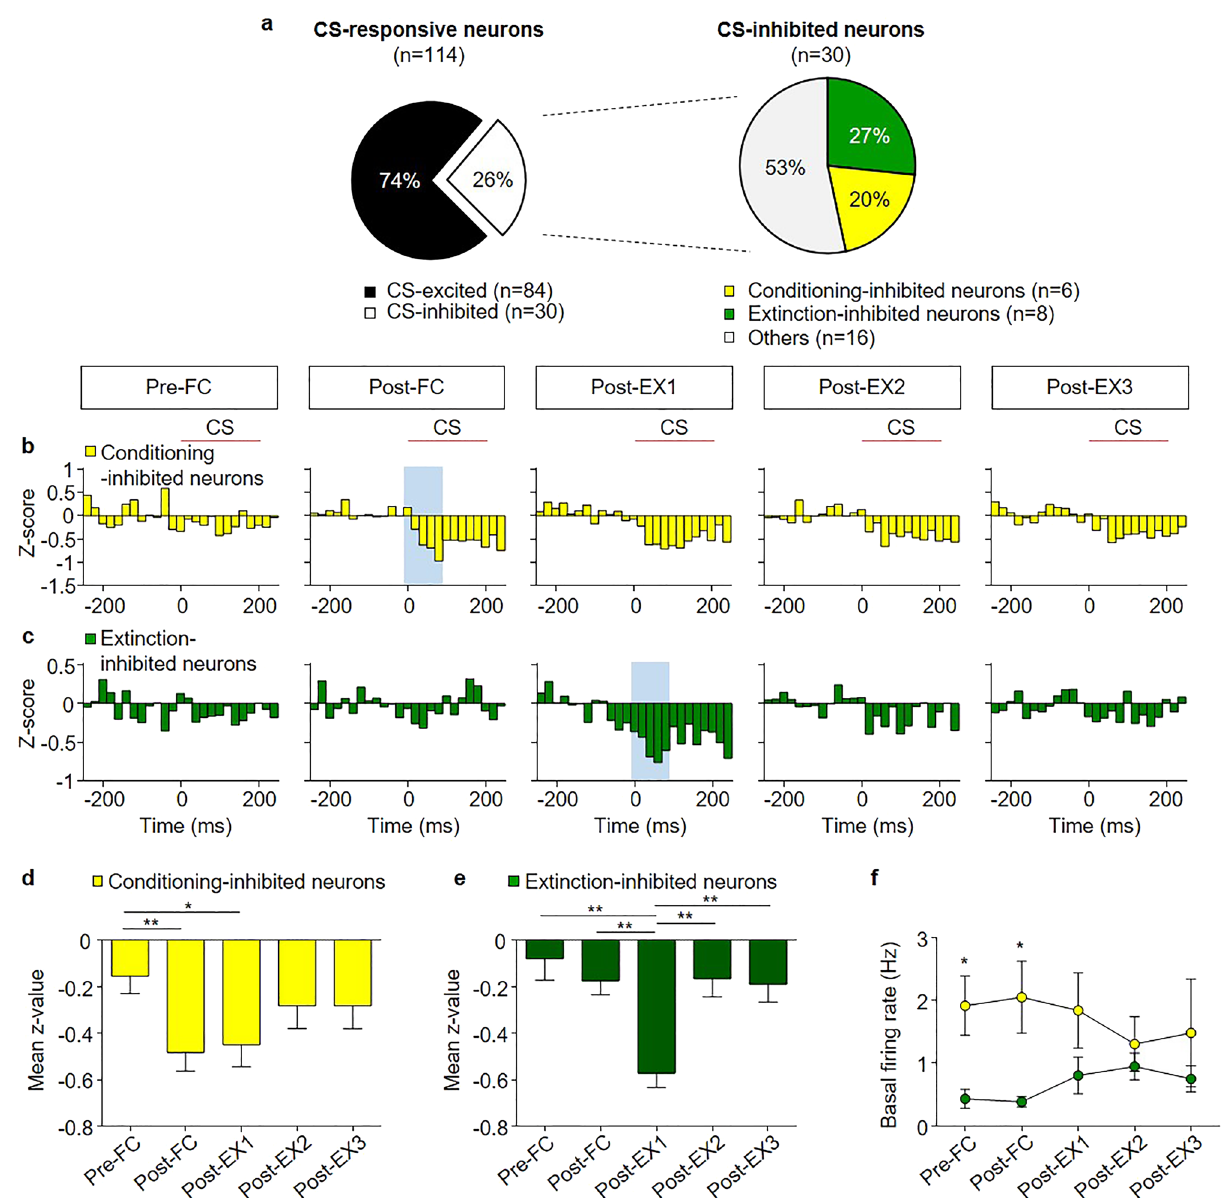
Figure 6. Distinct sub-populations of CS-inhibited neurons encode conditioning and extinction. ( a ) Pie chart showing the percentage of CS-inhibited neurons among the CS-responsive neurons (left) and the percentage of conditioning-inhibited and extinction-inhibited neurons among the CS-inhibited neurons (right). ( b ) Z-score PETH of conditioning-inhibited neurons (n = 6, 20% of CS-inhibited neurons). ( c ) Z-score PETH of extinction- inhibited neurons (n = 8, 27% of CS-inhibited neurons). ( d ) Mean z-score comparisons of the conditioning- inhibited neurons. ( e ) The mean z-score comparisons of extinction-inhibited neurons. ( f ) Comparison of basal firing rates of conditioning-inhibited (yellow circle) and extinction-inhibited neurons (green circle) across all behavioral sessions. * p < 0.05; ** p <